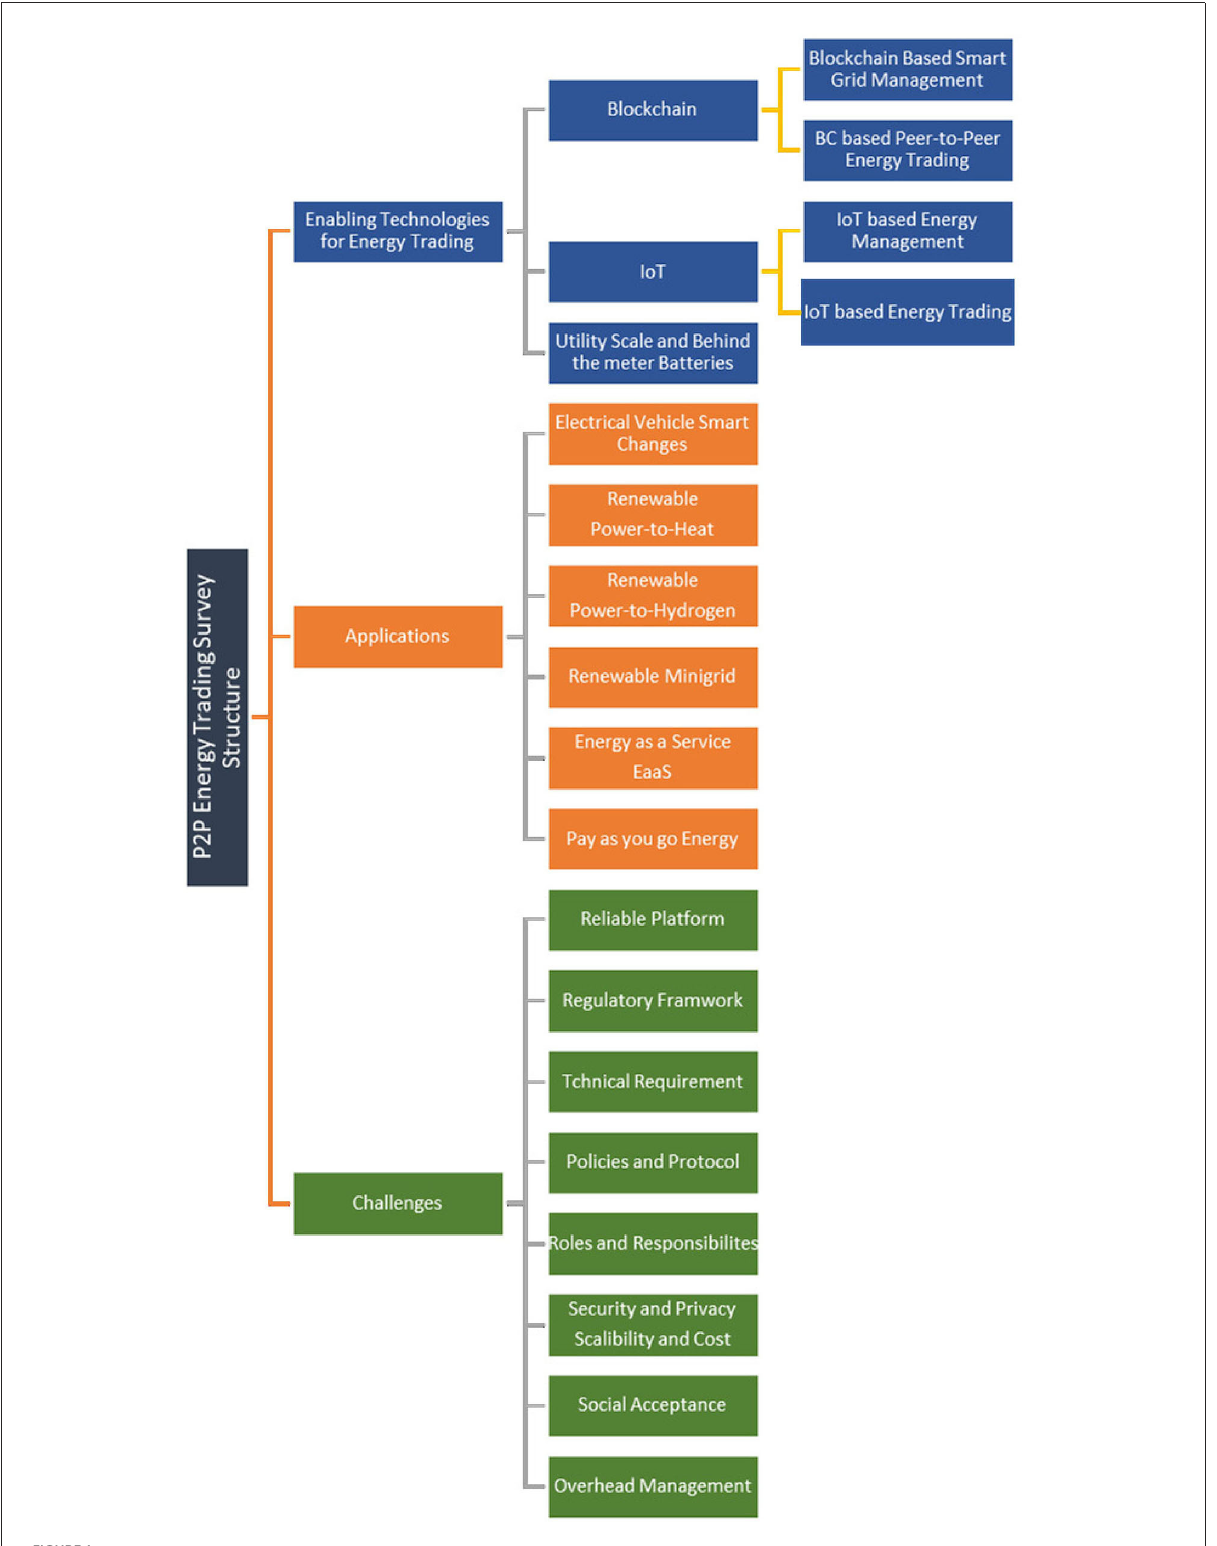
FIGURE1 Our study and classification of peer-to-peer Energy Trading technologies applications and